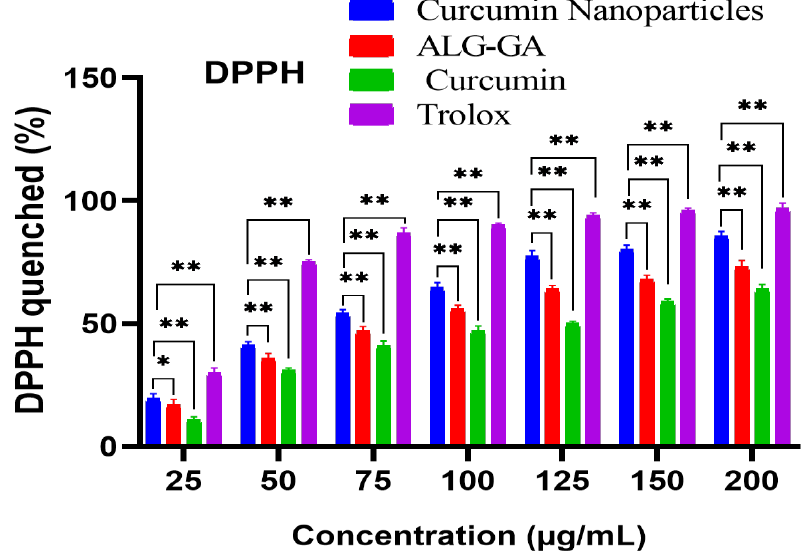
Figure 7. The DPPH scavenging activities at concentrations that affect ALG-GA nanoparticles, curcumin loaded in ALG-GA NPs, and Curcumin alone. Mean ± SD of three experiments.